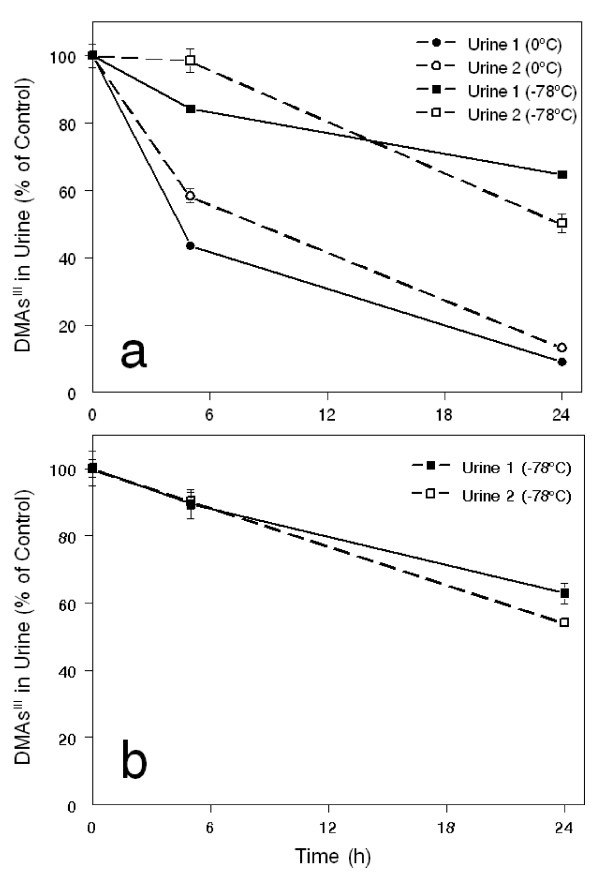
Effect of the storage time and temperature on DMAsIII oxidation in human urine. Spot urines from two subjects were spiked with iododimethylarsine (DMAsIIII) at final concentrations of 15 ppb As (a) or 100 ppb As (b). DMAsIII contents were determined in urines immediately after spiking (Control) and after 6 and 24 hours after spiking in urines stored either on ice (0°C) or in dry ice (-78°C). Mean ± SD are shown for n = 3.